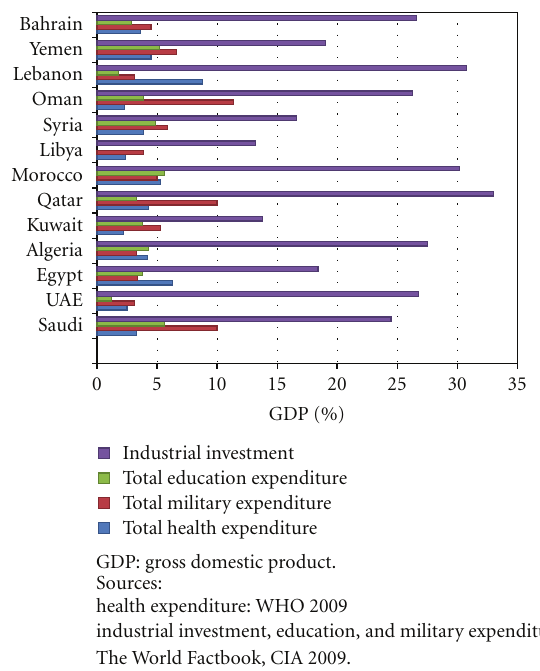
Figure 5: Industrial investment, military, education and health expenses percentage of GDP in selected Arabic-speaking